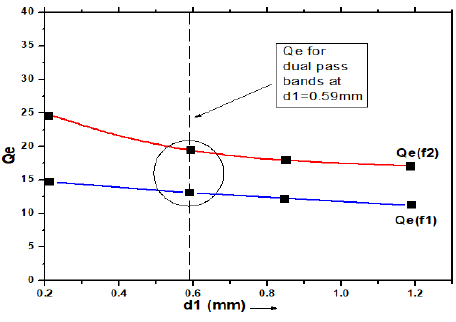
FIGURE 11. Q e of the proposed filter with